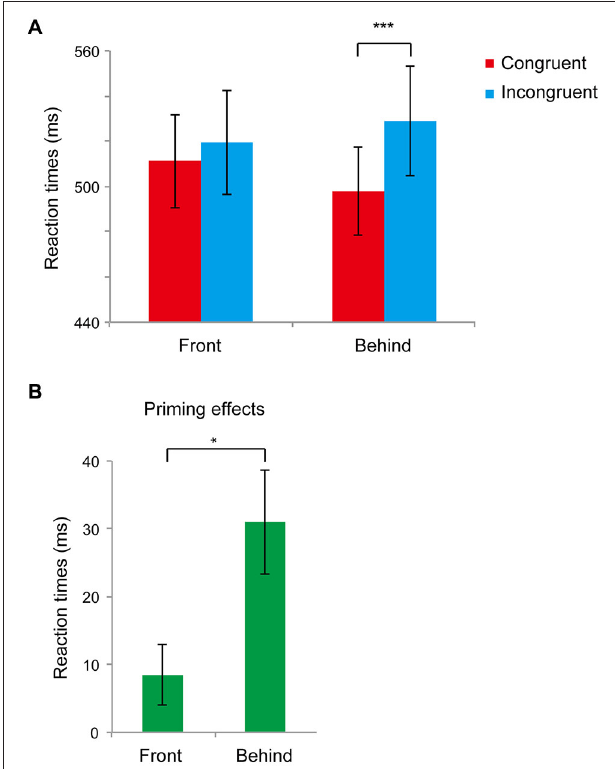
FIGURE 3 | Results of Experiment 2. (A) Mean reaction times (RTs) recorded in Experiment 2 in the front and behind conditions. The red bar represents the congruent condition (the face gender of the prime and target was the same); the blue bar represents the incongruent condition (the face gender of the prime and target was different). Bars represent standard errors (SEs) across participants. (B) Congruency effects (incongruent–congruent) of RTs in the front and behind conditions. Bars represent SE between participants. * P < 0.05, *** P <